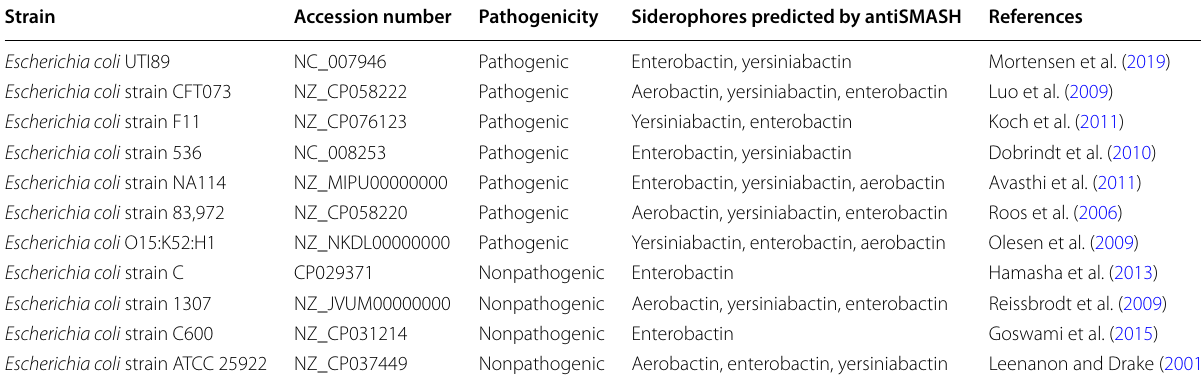
Table 2 Siderophores found in both pathogenic and nonpathogenic E. coli strains by antiSMASH analysis